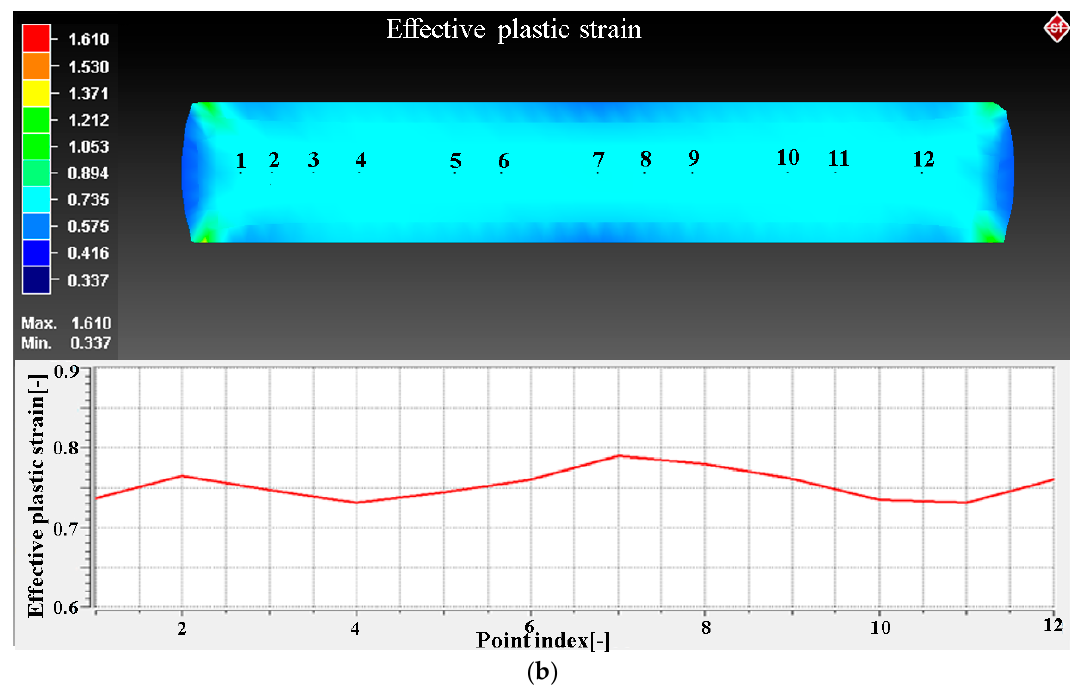
Figure 2. Simulation results of the effective strains produced from the deformed samples by using a set of ( a ) closed dies (hot forge); and ( b ) open dies (cold forge). Table 3. Parameters used for simulation in Simufact software